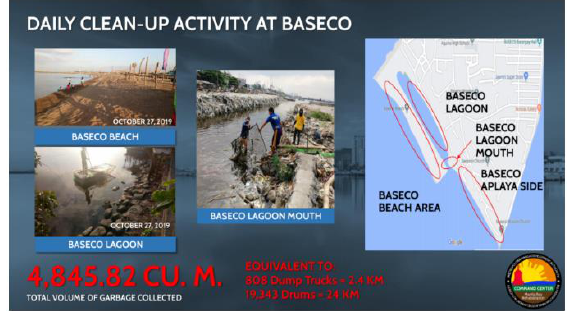
Figure 8 . Clean-up Activity Update from MMDA website.